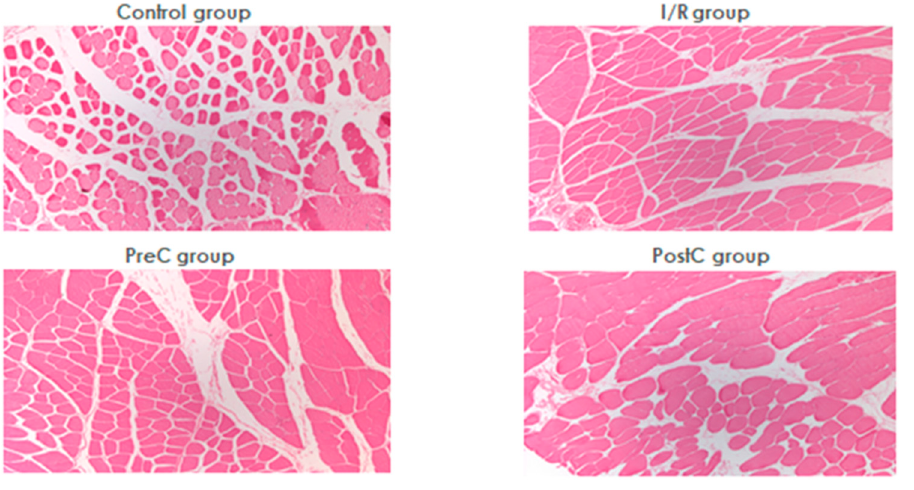
Figure 4. Representative histological slides of the skeletal muscle biopsies in the control, the ische- mia-reperfusion (I/R), the ischemic pre-conditioning (PreC), and the ischemic post-conditioning (PostC) groups. Staining: H&E; original magnification: 50×.